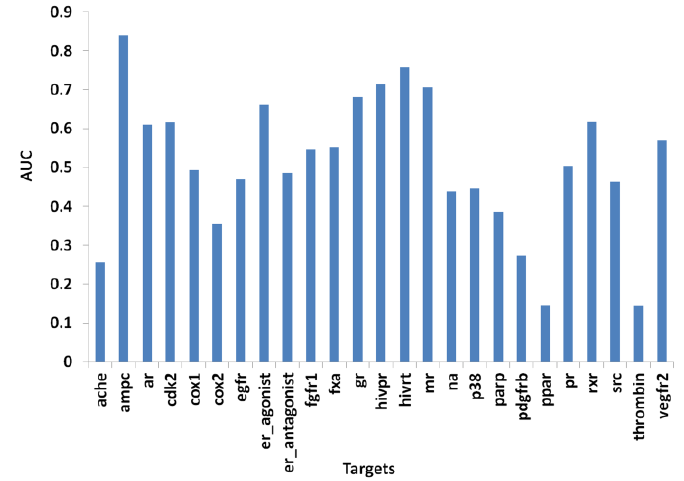
Figure 4. Area-under-the-curve (AUC) values for individual protein target. Enzyme